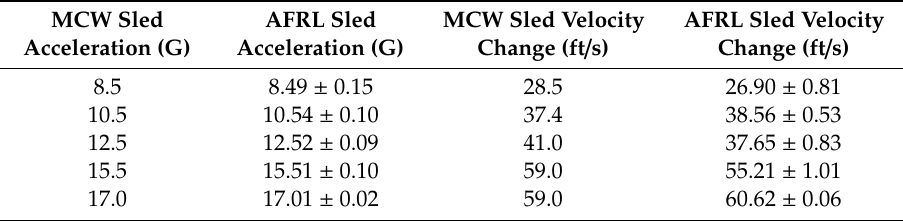
Table 2. Impact acceleration and velocity change comparison for AFRL and MCW Sleds.